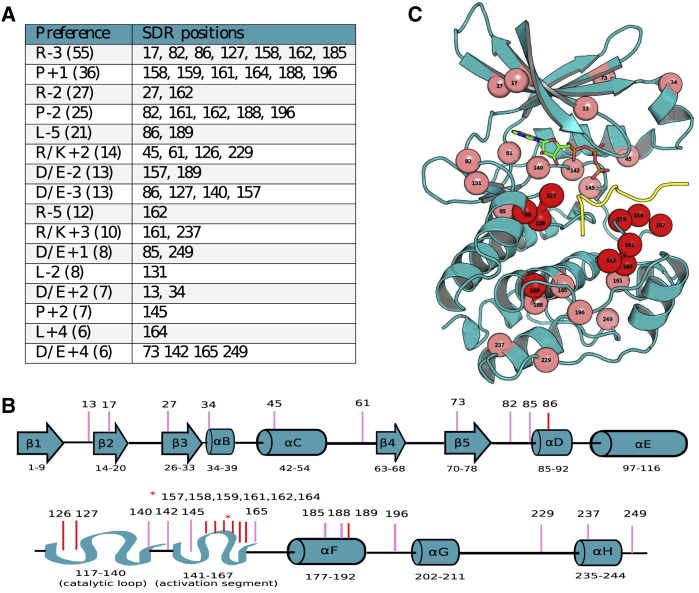
Position of Identified SDRs along the Kinase Sequence and StructureAll putative kinase SDRs from this analysis are (A) listed in a table with their corresponding position preferences, (B) mapped to a 1-dimensional (1D) representation of the kinase secondary structure, and (C) mapped to a kinase-substrate complex structure (PDB: 1ATP). The SDRs colored in dark red (B) and (C) represent positions within 4 Å of the substrate peptide. Residue numbering represents the relevant positions of the Pfam protein kinase domain (PF00069). The numbers in brackets for (A) represent the number of kinases with the given specificity.